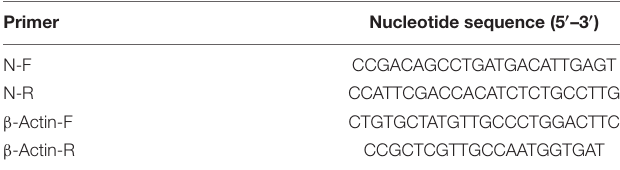
TABLE 2 | Primers used for measuring the N gene of VSV and β -actin. Primer